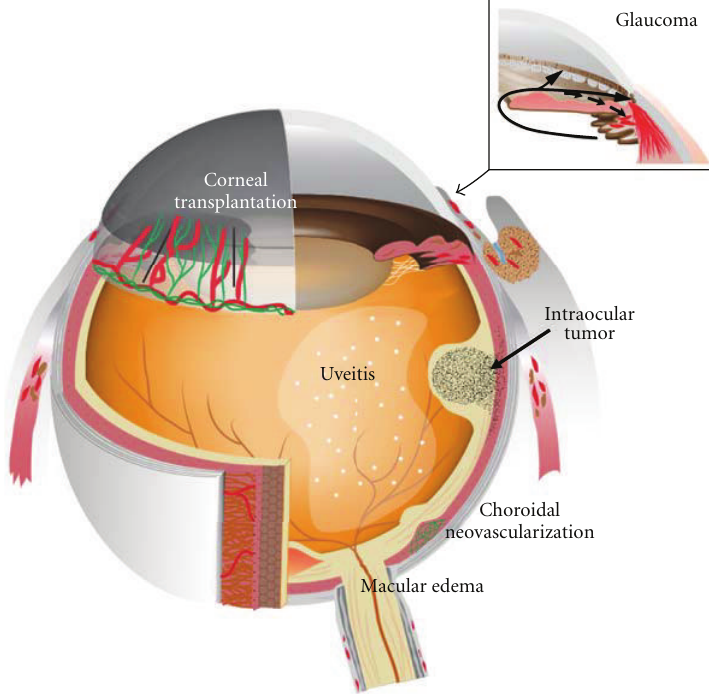
Figure 4: Lymphangiogenesis as a possible therapeutic target for the eye diseases. Corneal transplant, glaucoma, and intraocular tumors were suggested to be related to lymphatics or lymphangiogenesis in the pathogenesis. If choroid has lymphatic function, lymphatics or lymphangiogenesis may be important for the pathology of uveitis, choroidal neovascularization, or macular edema because of the vital role of lymphatics in inflammation or tissue edema. Red: lymphatic vessels. Green: blood